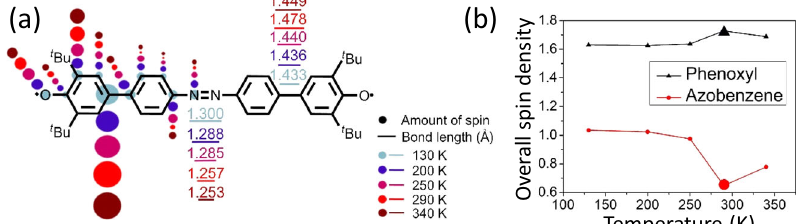
Fig. 5 Spin density distribution of CAR. a Selected bond lengths and calculated spin population of CAR at different temperatures. b The integral spin density changes of phenoxyl and azobenzene moieties at temperatures of 130, 200, 250, 290, and 340 K.